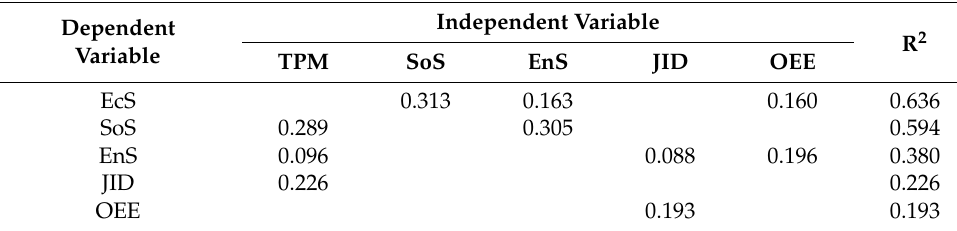
Figure 3. The tested model of the relationships between LMTs and sustainability. Table 4. Effect sizes for direct